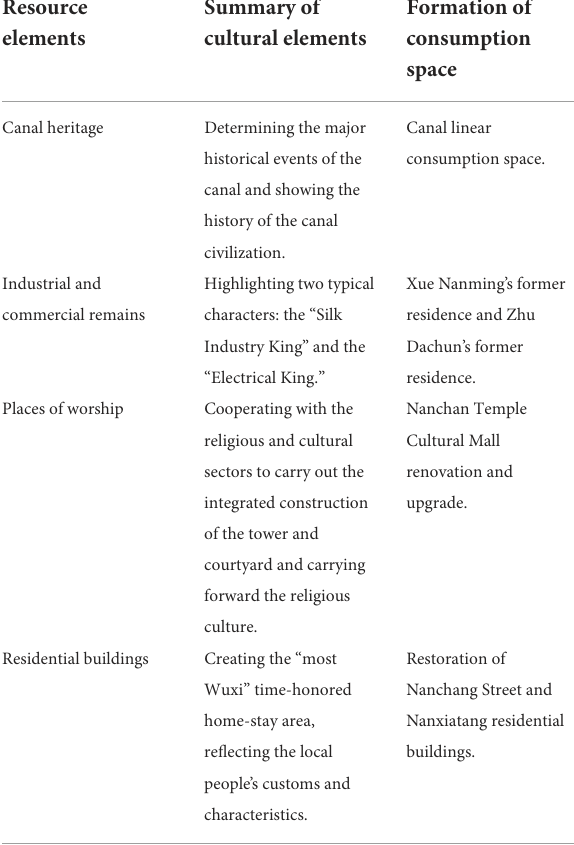
TABLE 1 Summary and development update of intangible cultural